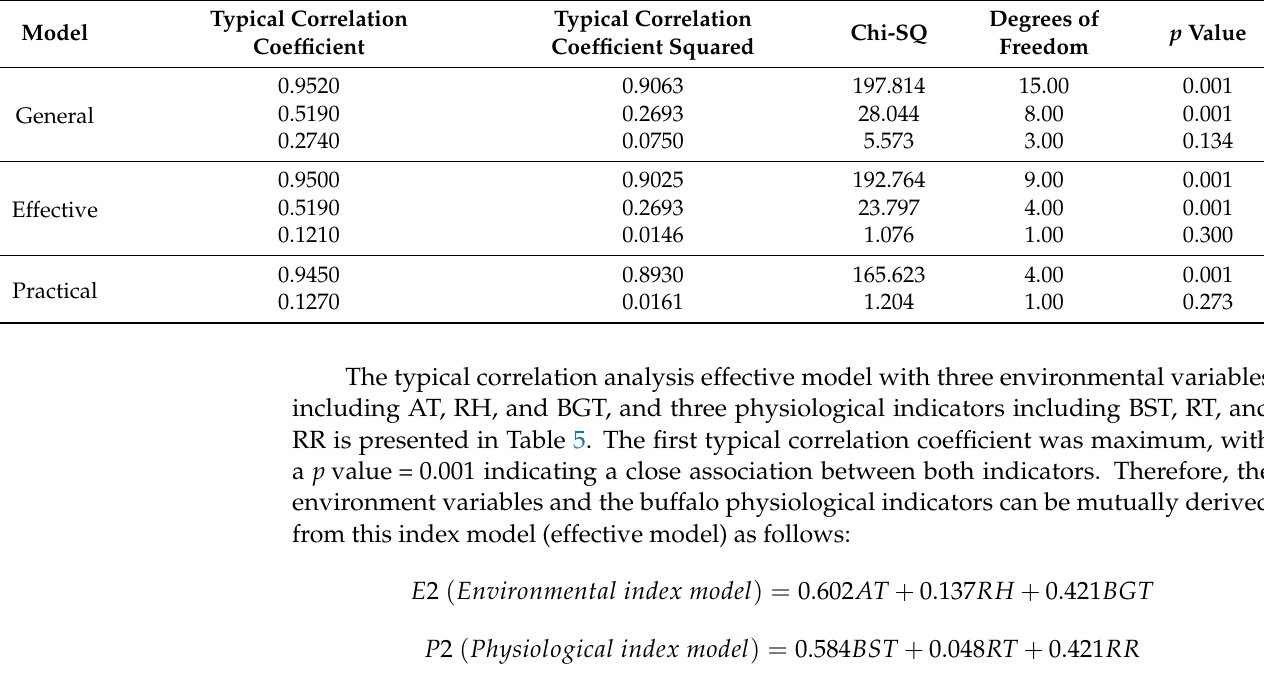
Table 4. Analysis of typical correlation coefficients between environmental variables of buffalo house and physiological indicators of lactating buffaloes (general model). Model